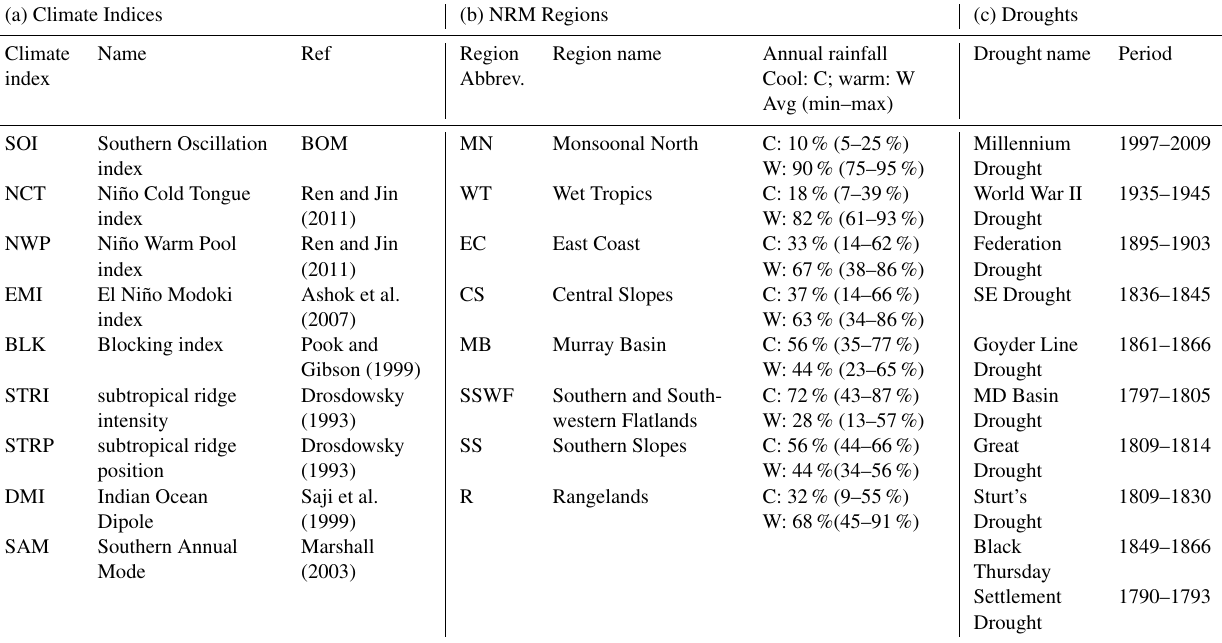
Table 1. Summary of climate drivers, regions and droughts used in this study. (a) Climate indices and references for computational informa- tion; (b) mean, minimal and maximal seasonal contributions to annual rainfall totals (in %) for natural resource management (NRM) regions of Australia; and (c) instrumental and historical